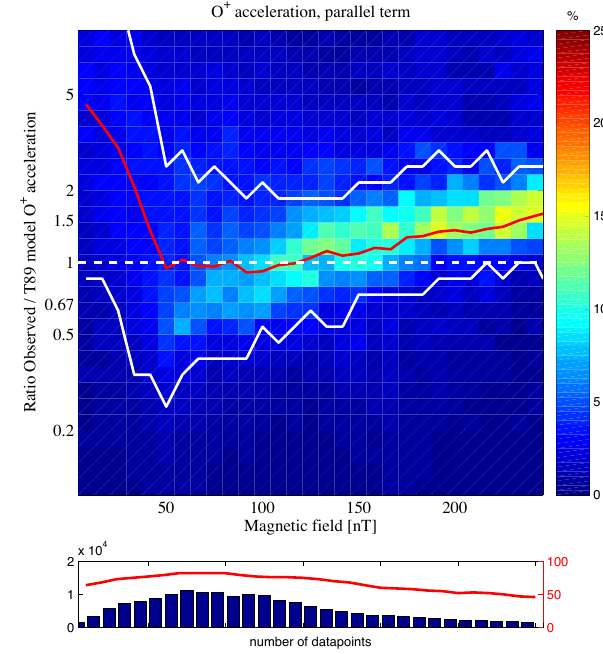
Fig. 6. Upper panel: Distribution of the ratio of the perpendicular term of the centrifugal acceleration of O + (positive in direction of outflow) from observed magnetic field values and with magnetic field values from the Tsyganenko 89 model, for each interval of magnetic field strength [nT]. Each column is normalized, the sum of all data bins in a column is 100% if all data points are contained in the plotted region. White lines indicate the narrowest region around the maximum in each column which contains 50% of all data points. A red line shows the median value of the parallel velocity ratio for each magnetic field interval. Lower panel: Number of data points contributing to each column (blue bars, left y-axis), and the number of measurement days contributing to the column (red line, right y-axis).